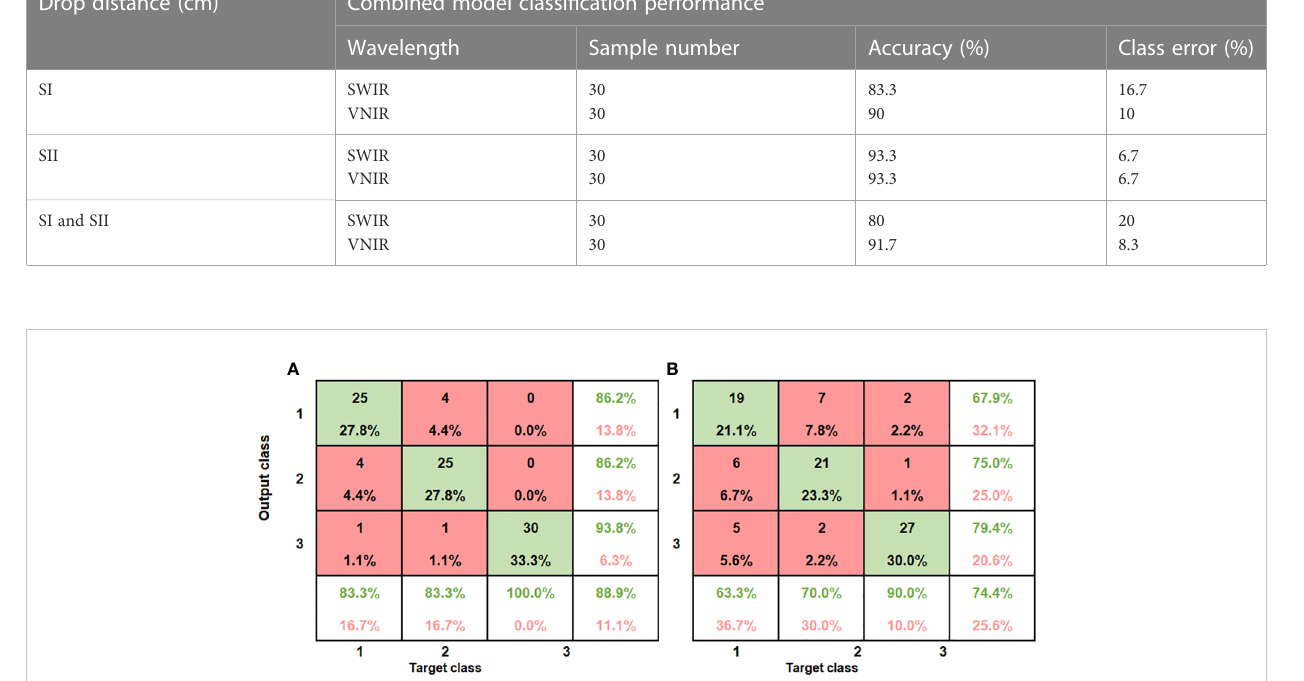
TABLE 3 Combined performance of the classi fi cation model for bruise severity detection on pomegranate fruit. Drop distance